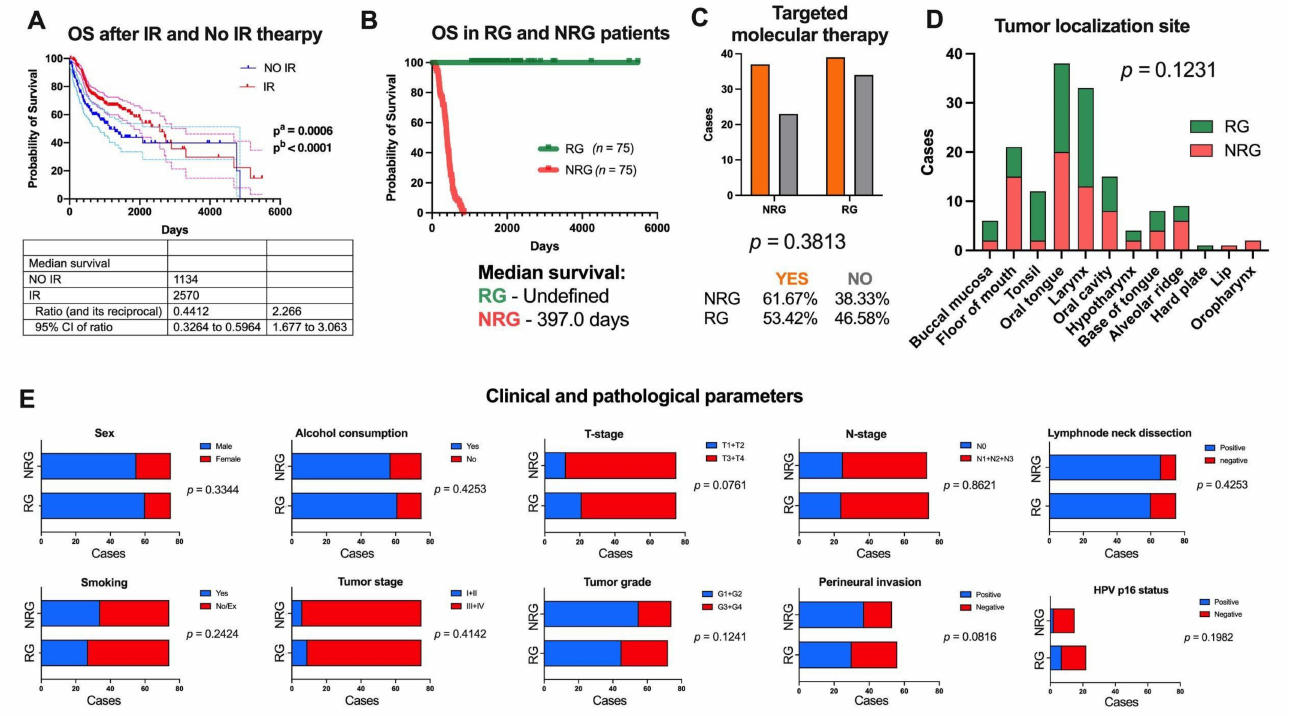
Figure 2. Characteristics of an in silico model obtained based on the TCGA head and neck squamous cell carcinomas (HNSCC) patients: ( A ) overall survival (OS) time of HNSCC patients depending on radiotherapy (IR, dark red) and no radiotherapy (No IR, dark blue) treatment with 95% CI marked as lighter lines; ( B ) OS time in responders group (RG, green) and non-responders group (NRG, red) of patients to radiotherapy; ( C ) percent of the patients who underwent targeted molecular therapy; ( D ) localization of tumors depending on the RG and NRG groups; and ( E ) main clinical and patho- logical parameters describing RG and NRG groups; p < 0.05 considered as statistically